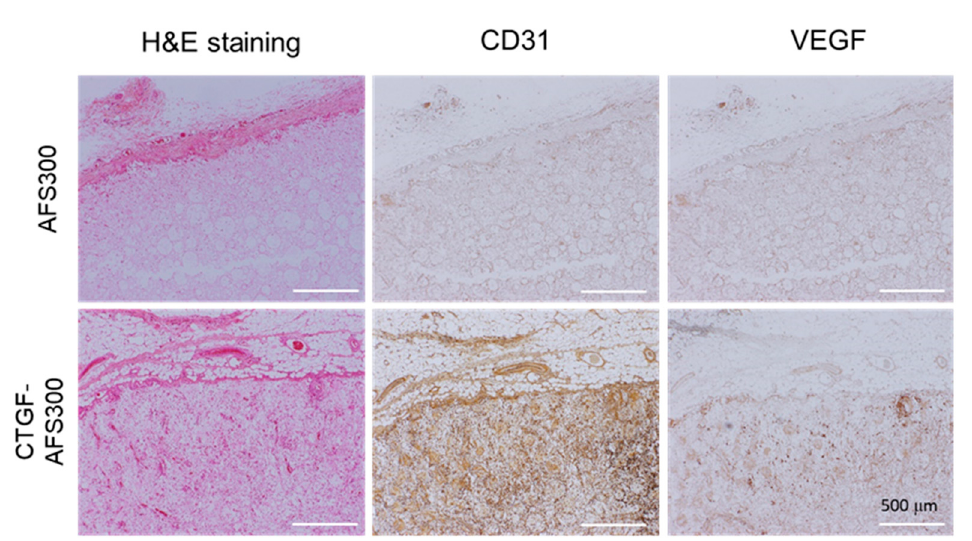
Figure 7. Immunohistochemical analysis of angiogenesis. H&E staining was performed on tissue sections. Thin sections were also immunostained with CD31 and VEGF as a marker of endothelial cells (Brown DAB staining). Cells were penetrated both AFS and CTGF-loaded AFS. CTGF(1000)-AFS300 displayed a higher density of cells including vessels. Scale bars indicate 500 µ m, respectively.